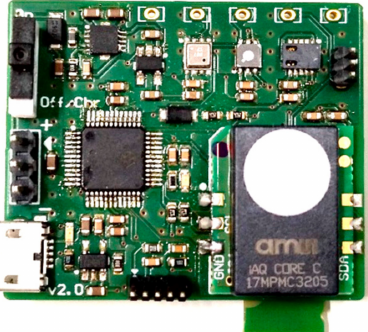
Figure 2. Developed electronic nose.